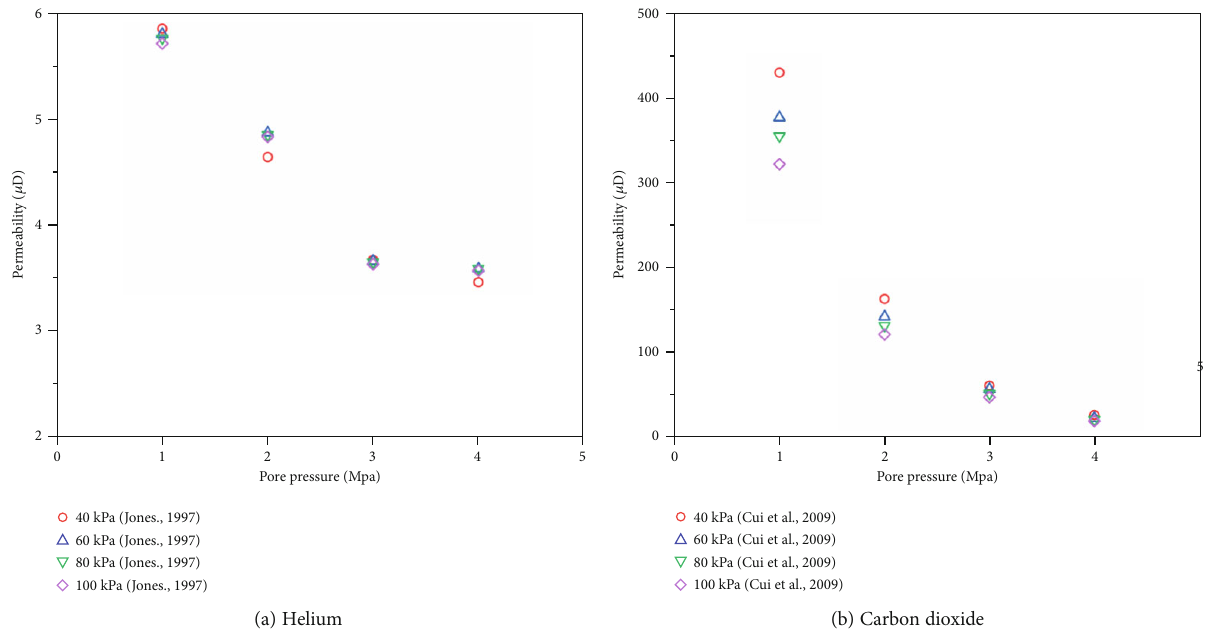
Figure 6: Gas permeability under di ff erent pore pressures ( net confining pressure = 3 MPa ).